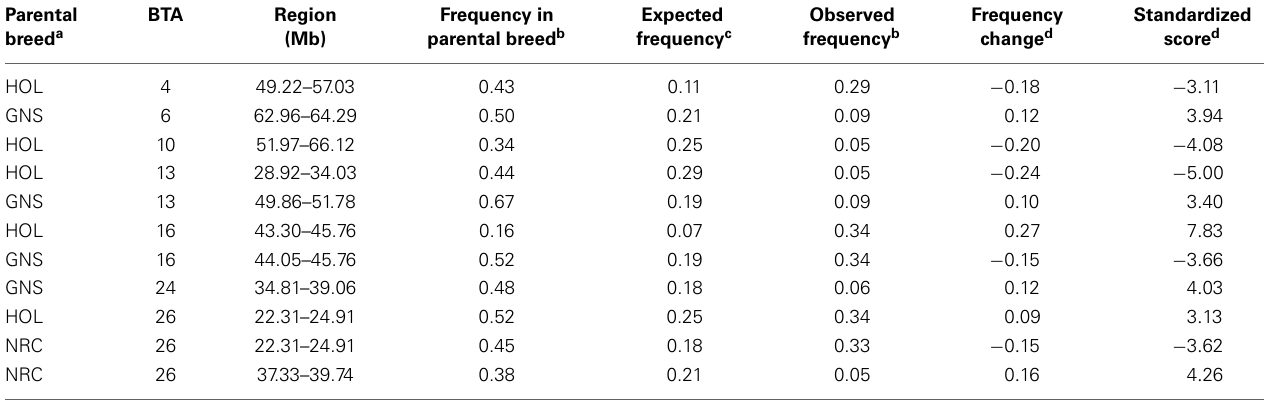
Table 1 | Comparisons of the most frequent consensus haplotype in parental breeds and Kenyan crossbreds. Parental BTA Region Frequency in Expected Observed Frequency Standardized breed a (Mb) parental breed b frequency c frequency b change d score